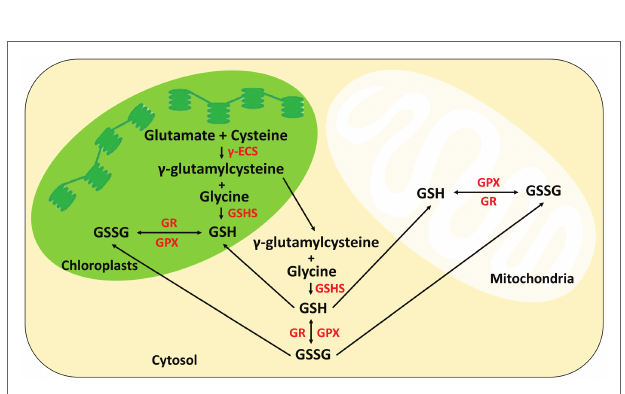
FIGURE 2 | Illustration of biosynthesis and simple metabolism of GSH in plant